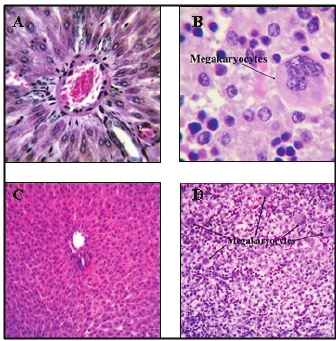
FIGURE 4 - Photomicrograph of the liver of a newborn, with hematoxylin-eosin staining: A . Control group without megakaryocytes, with objective lens of 100x; B . Experimental group with megakaryocytes, with objective lens of 100x; C . Control group without megakaryocytes, with objective lens of 10x; D . Experimental group with megakaryocytes, with objective lens of 10x.